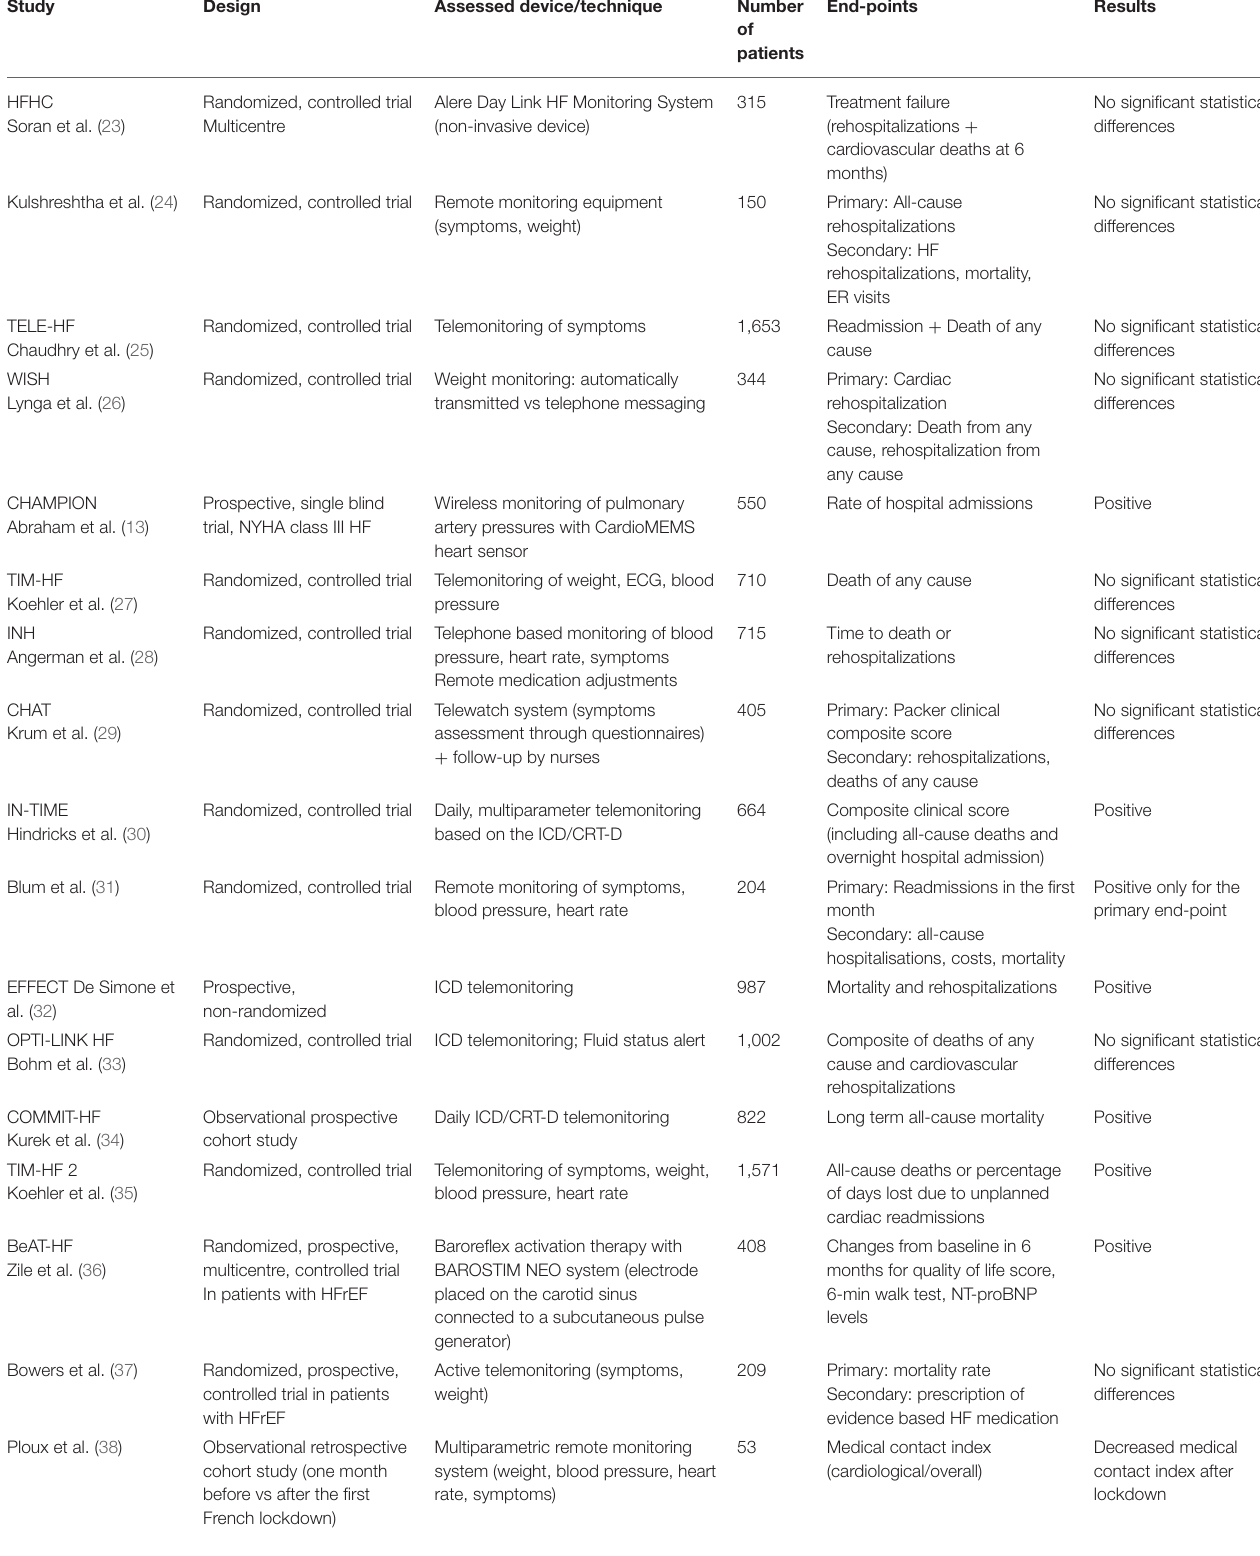
TABLE 2 | Summary of different heart failure telemedicine